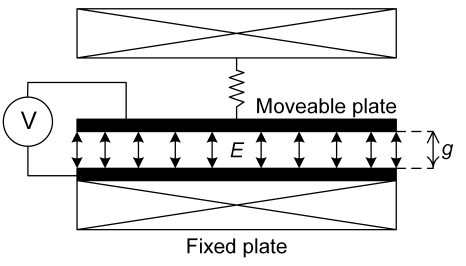
Figure 1. Mass-spring model representation of electrostatic transduction on a microelectromechanical systems (MEMS) resonator.